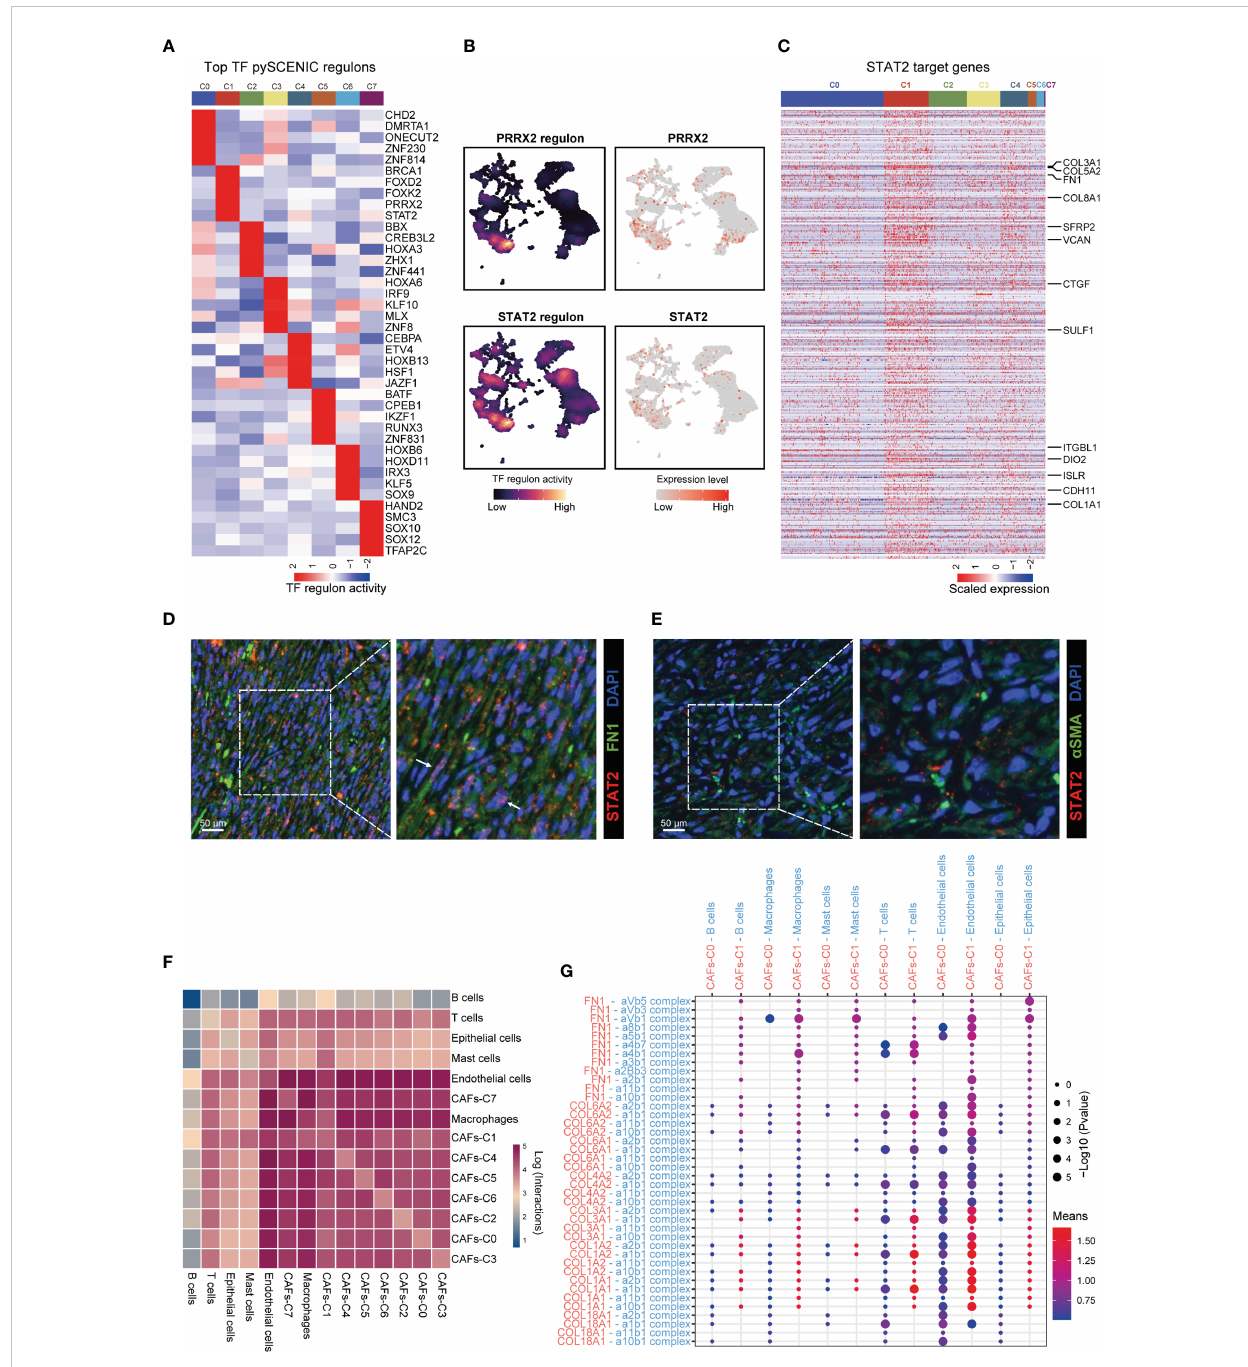
FIGURE 3 Gene regulatory programs and cell-cell communication networks associated with CAFs subtypes. (A) Heatmap showing the regulon activities of top 5 activating transcriptional factors for each CAFs subtype predicted by pySCENIC. (B) UMAP plot showing the PRRX2- and STAT2-regulon activity predicted by pySCENIC. (C) Heatmap showing the expression levels of STAT2 target genes in each CAFs subtype. Upregulated DEGs of CAFs-C1 were labeled. (D) Representative fl uorescence images of STAT2 + FN1 + CAFs from prostate cancer samples. Scale bar, 50 m m. (E) Representative fl uorescence images of STAT2 and a SMA-stained prostate cancer samples. Scale bar, 50 m m. (F) Heatmap showing the number of potential cell-cell interactions between CAFs and all other cell types predicted by CellPhoneDB. (G) Dot plot of representative cell-cell interactions between CAFs-C0, CAFs-C1, and all other cell